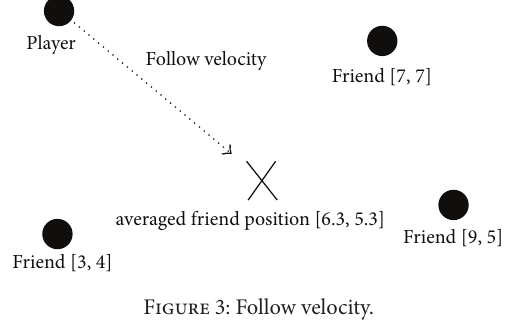
Figure 3: Follow